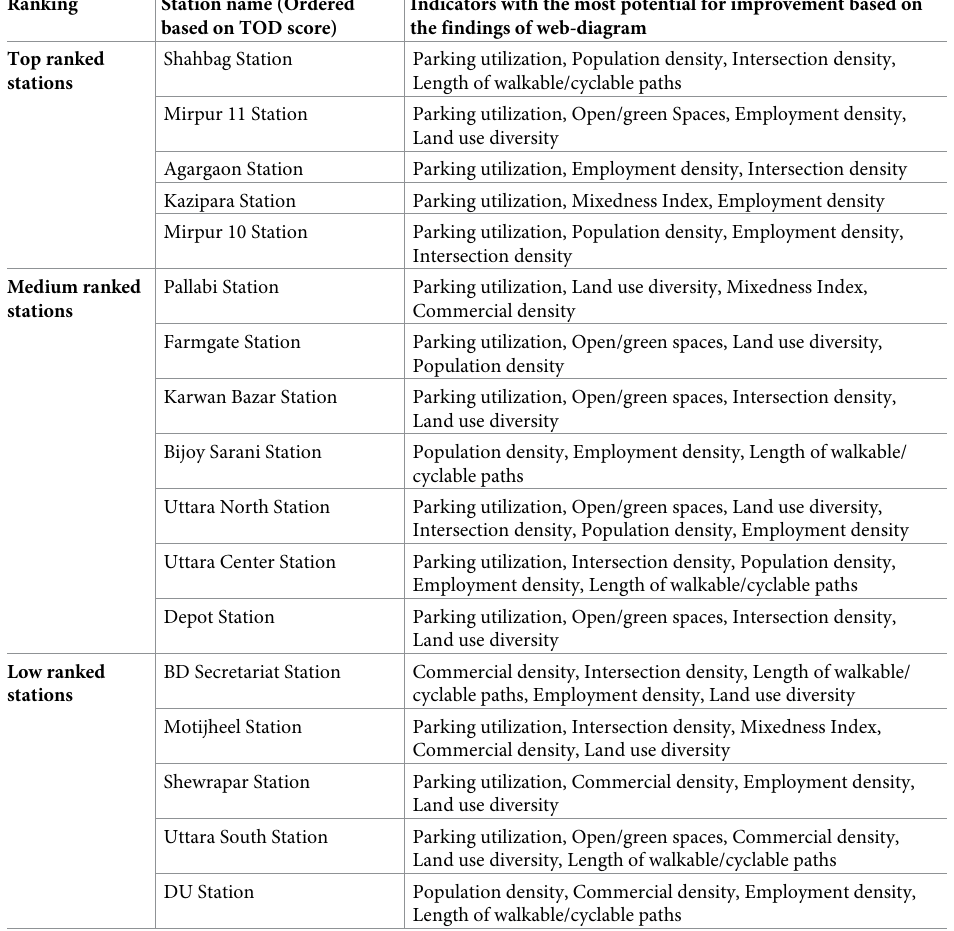
Table 6. Indicators with most potentials for